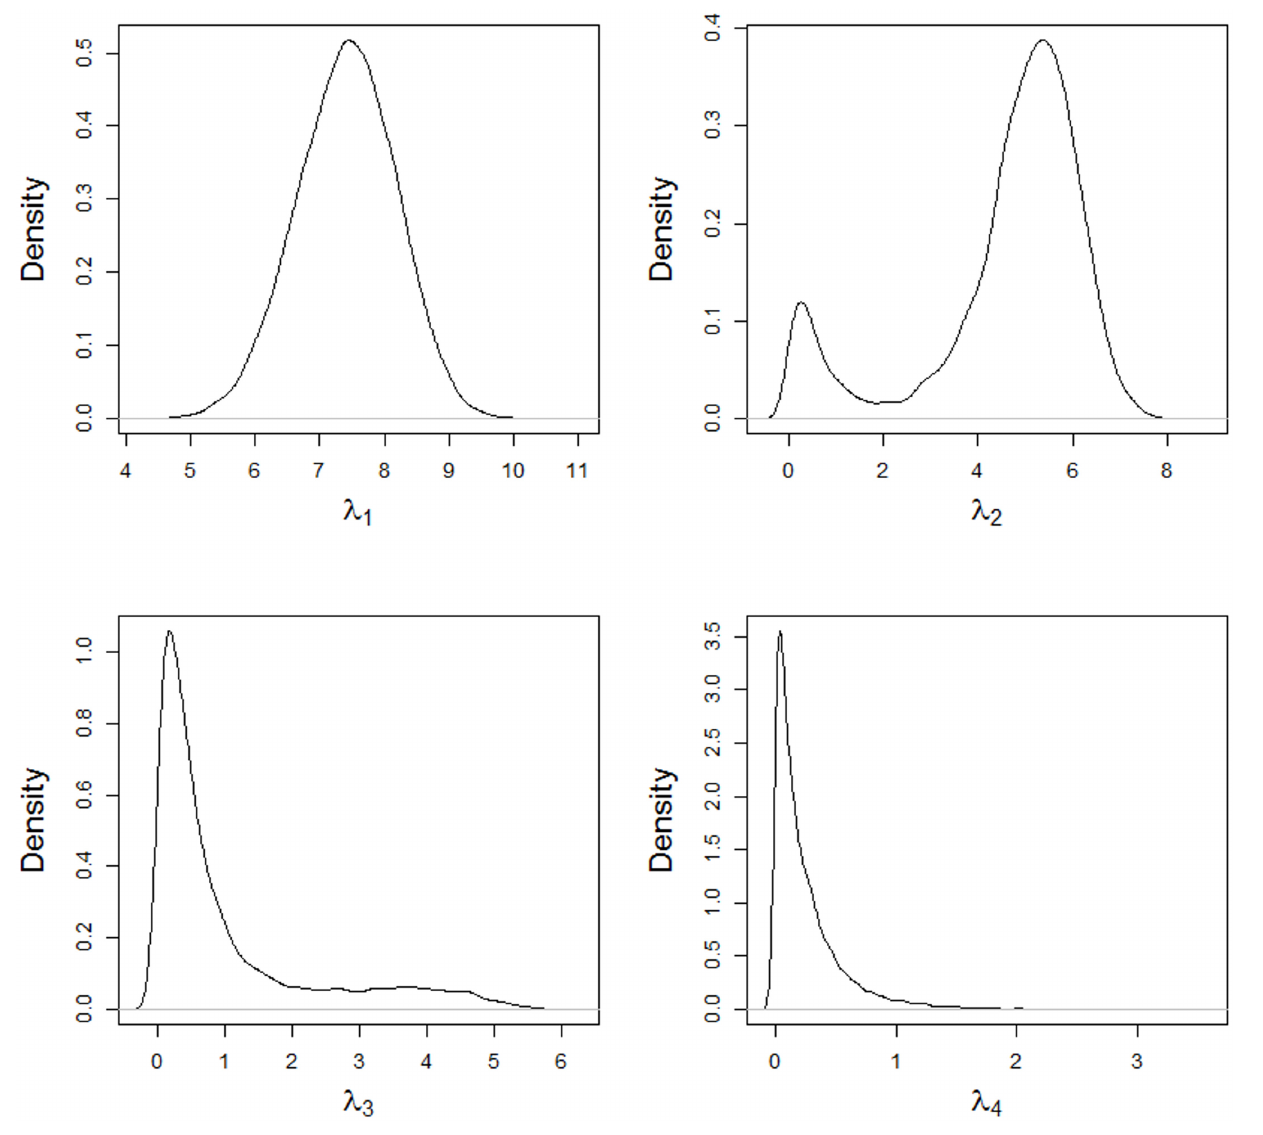
Fig 4. Posterior densities of the singular values λ 1 , λ 2 , λ 3 and λ 4 , obtained using the AMMIBS